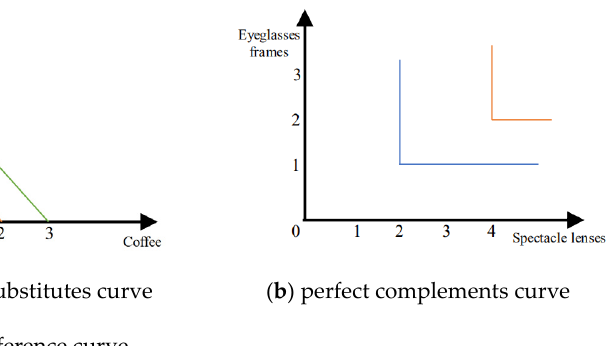
Figure 6. Three − dimensional indifference curve of the perfect substitution utility function. The perfect substitution utility function has excellent theoretical support as a type of utility function. However, in federated learning, the training usually involves multiple